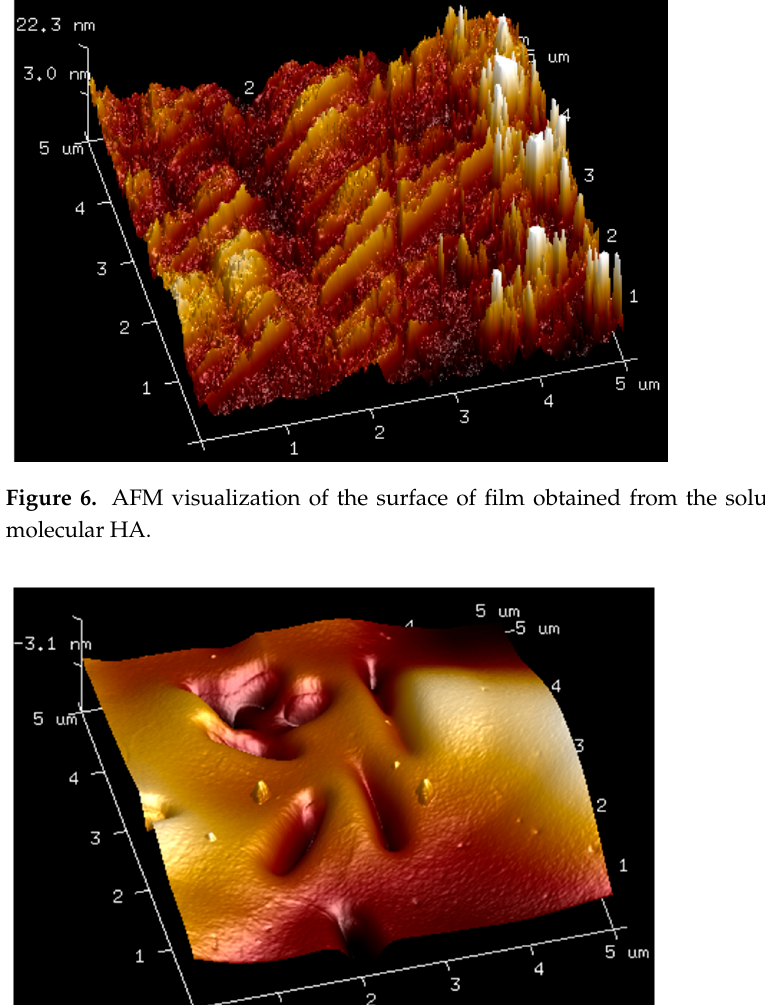
Figure 7. AFM visualization of the surface of film obtained from the solution of 1.5% high-molecular HA with 1% BSA.